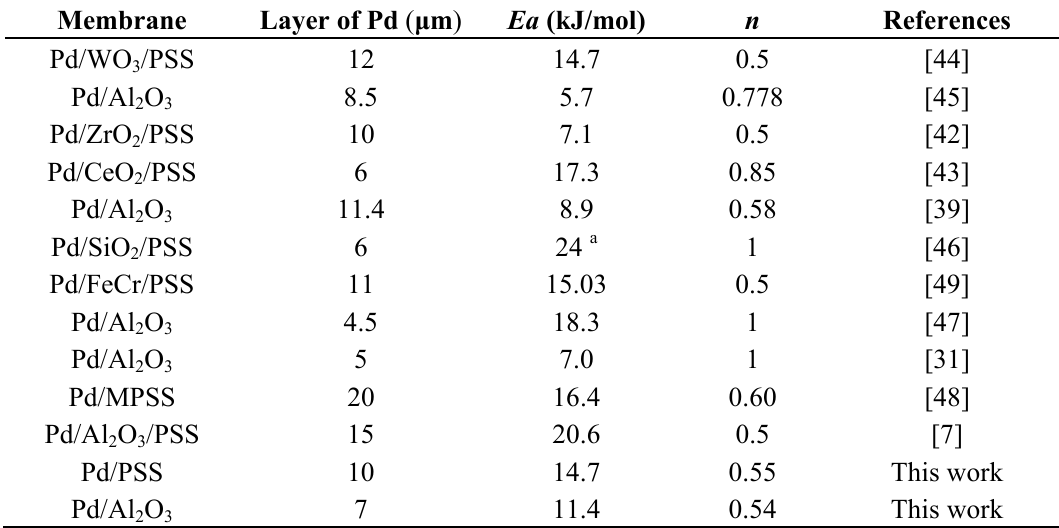
Table 2. Comparison of Ea and n values determined for both Pd/PSS and Pd/Al membranes with respect to similar data on Pd-based membranes reported in the